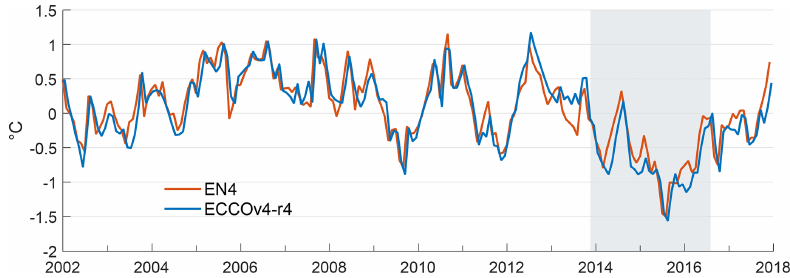
Figure 2. Time series of anomalies in the mixed-layer average potential temperature ( ◦ C), relative to the 1992–2015 monthly climatology, averaged over the cold blob region, for EN4 observations (red) and ECCOv4-r4 (blue). The shaded area marks the time period from when the initial cold anomaly begins to emerge to when the anomaly once again becomes